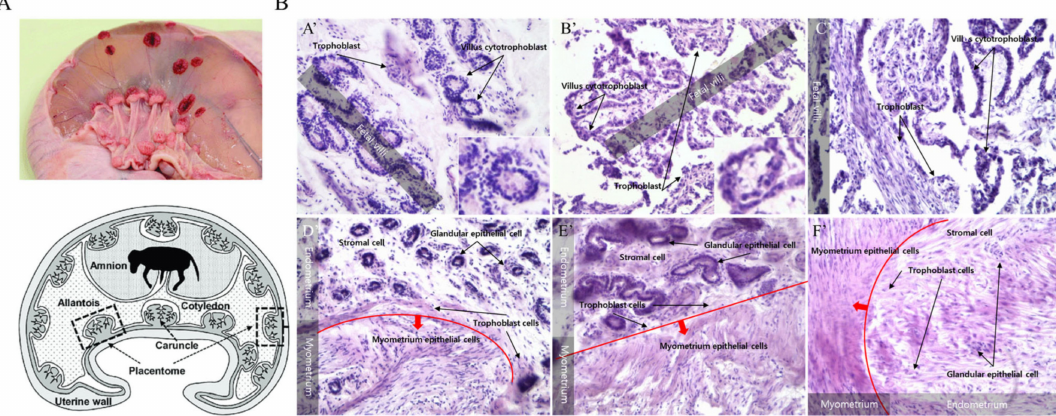
Figure 1. Histological analysis of bovine uterus and caruncle during early pregnancy. Microscope (Nikon Corp., Tokyo, Japan) magnification = × 200. ( A ) Anatomy of the caruncle [19]. ( B )